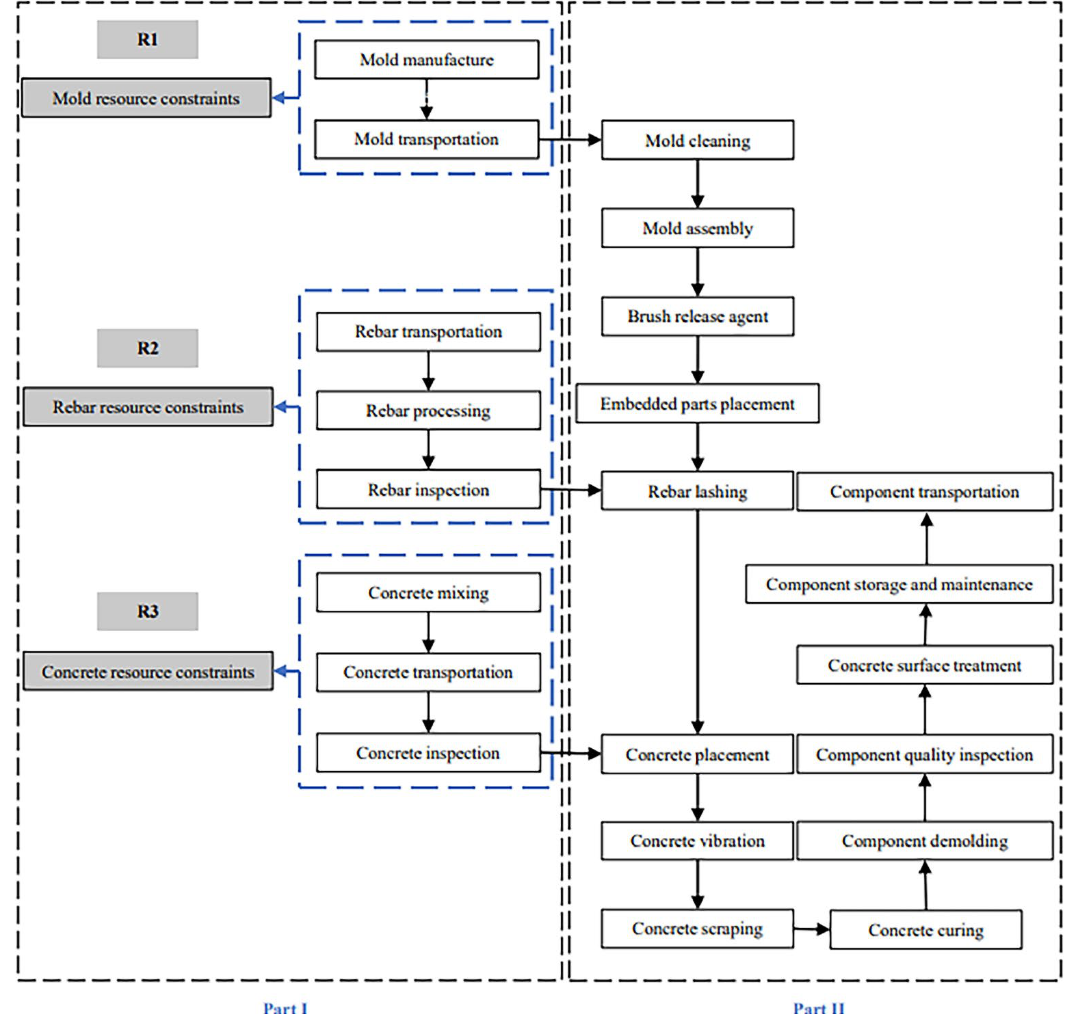
Figure 1. Precast component production process from the perspective of the entire supply